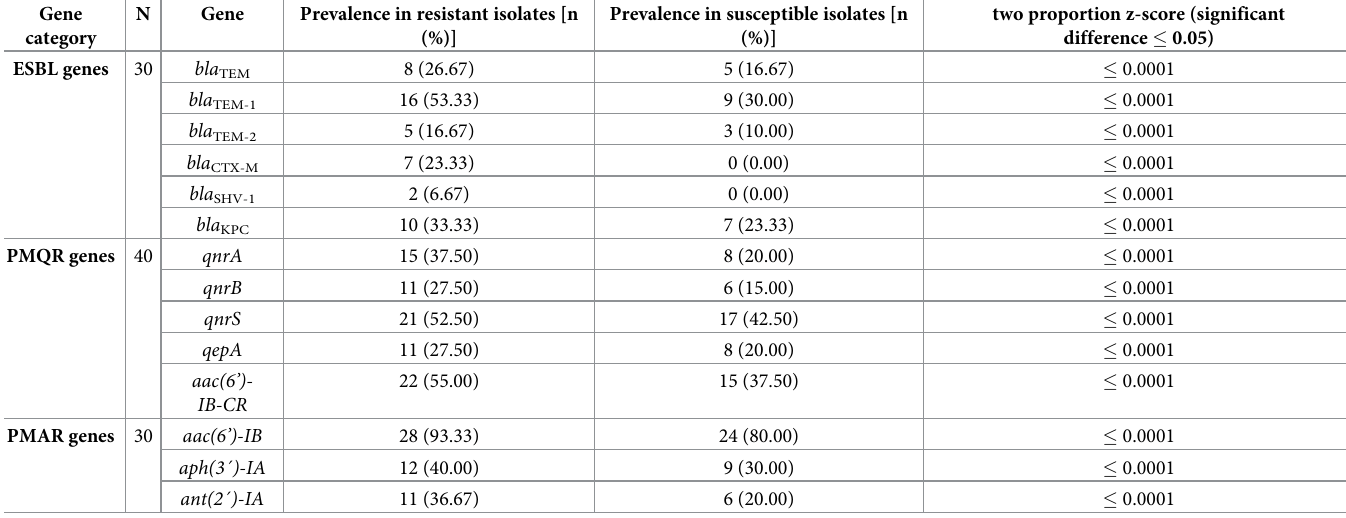
Table 8. Detailed prevalence of the individual resistance genes in resistant and susceptible isolates.